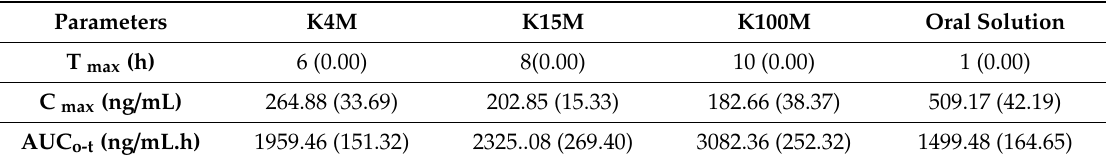
Figure 11. Drug (glipizide) absorption vs time profile of 3D printed HPMC matrix tablets. Table 7. Pharmacokinetic parameters of hypromellose / glipizide hydrophilic matrices (n = 5, standard deviations are in parenthesis).